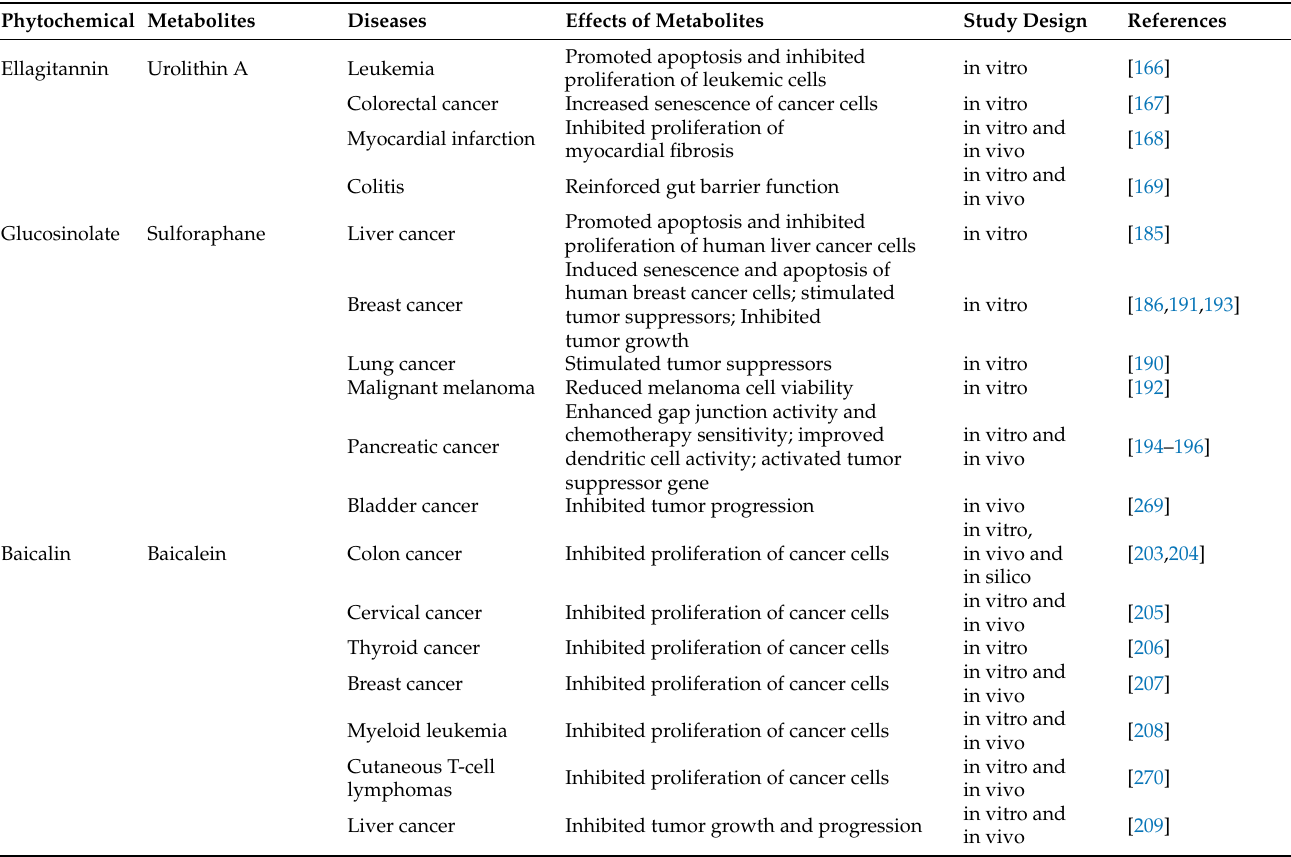
Table 1. Phytochemical metabolites and their effects on human disease. Phytochemical Metabolites Diseases Effects of Metabolites Study